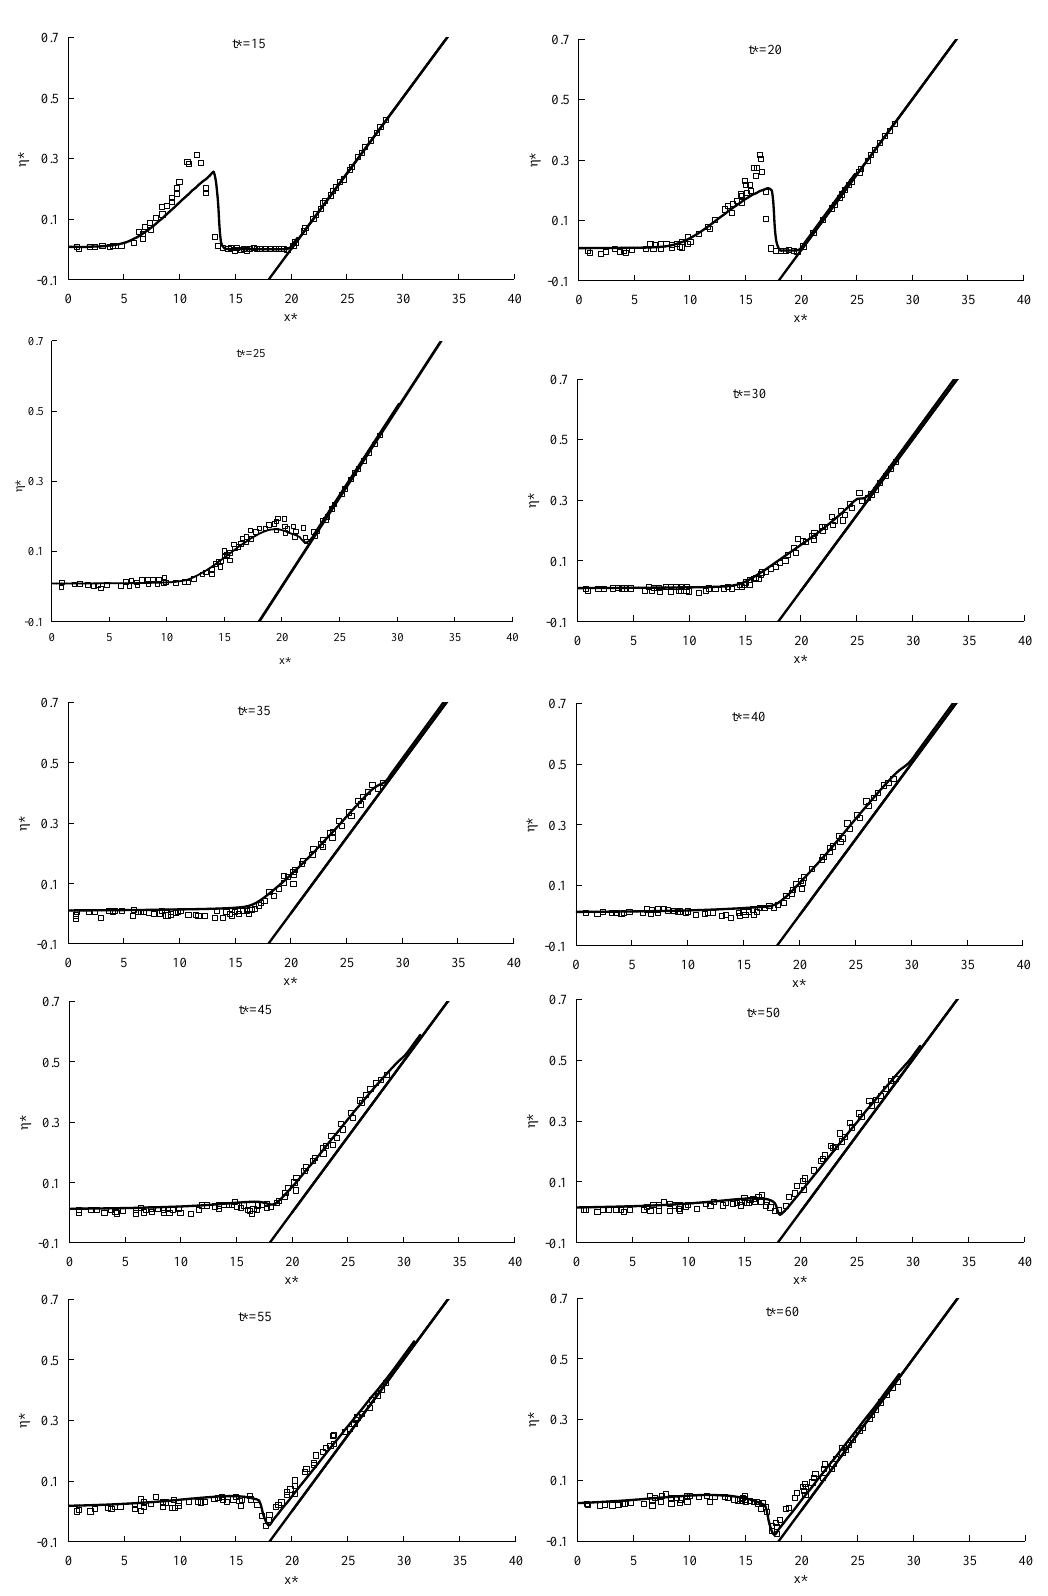
Figure 3. Run-up and run-down of H w /h 0 = 0.0185 non-breaking solitary wave on a 1:19.85 sloping beach.